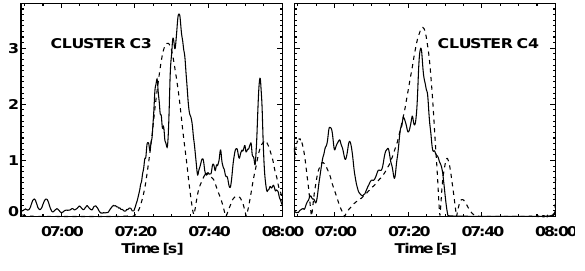
Fig. 11. Comparison between measurement of the b r (solid line) component and the model of the wave field b r,model (dashed line).